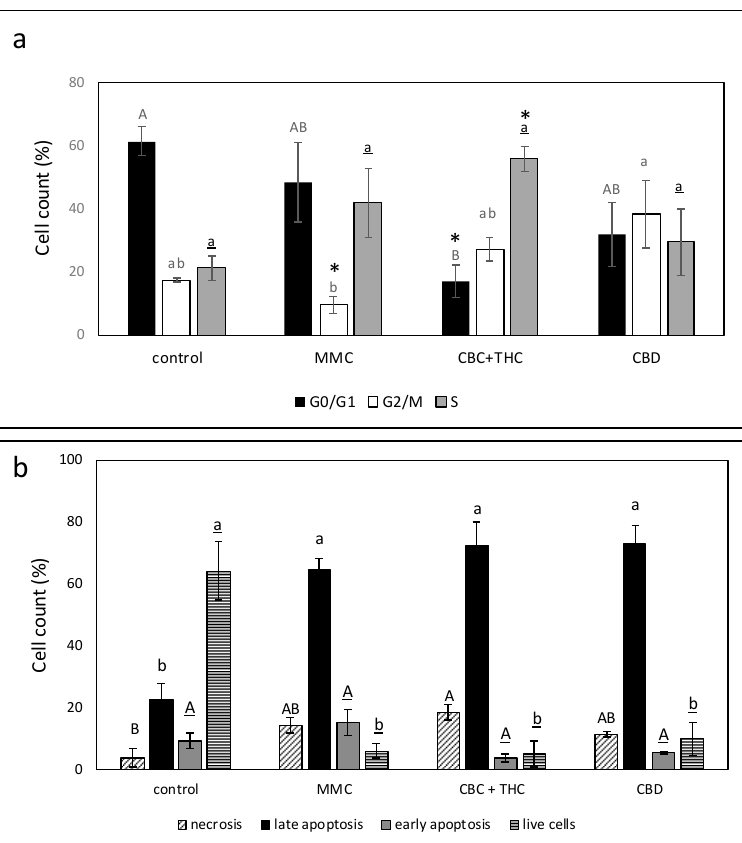
Figure 4. ( a ) Determination of the stages of cell cycle arrest following treatment with CBC + THC (17.2 + 2.8 µg/mL, respectively) or CBD (15 µg/mL) on the T24 cell line for 24 h. Mitomycin-C (MMC, 8 µg/mL) served as a positive control. Methanol (control) treatment served as a solvent (vehicle) control. Error bars indicate ± SE ( n = 3). Levels with different letters of the same font are significantly different from all combinations of pairs according to Tukey–Kramer honest significant difference (HSD; P ≤ 0.05). * indicates significantly different mean from the control based on Student t -test ( P ≤ 0.05). ( b ) Proportion of viable, apoptotic, or necrotic cells following treatment with CBC+THC (17.2 + 2.8 µg/mL, respectively) or CBD (15 µg/mL) on T24 cell line for 48 h. Mitomycin-C (MMC, 8 µg/mL) served as a positive control. Methanol (control) treatment served as solvent (vehicle) control. Error bars indicate ± SE ( n = 3 for treatments, n = 4 for the control). Levels with different letters are significantly different from all combinations of pairs according to Tukey-Kramer honest significant difference (HSD; P ≤ 0.05).